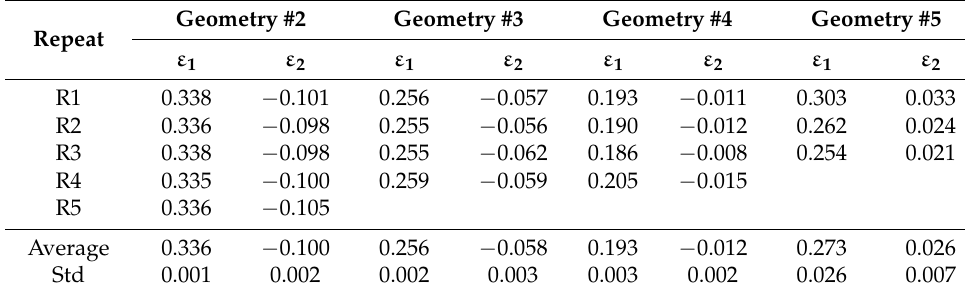
Table A1. Forming limit strains obtained in Marciniak tests for the 590R.